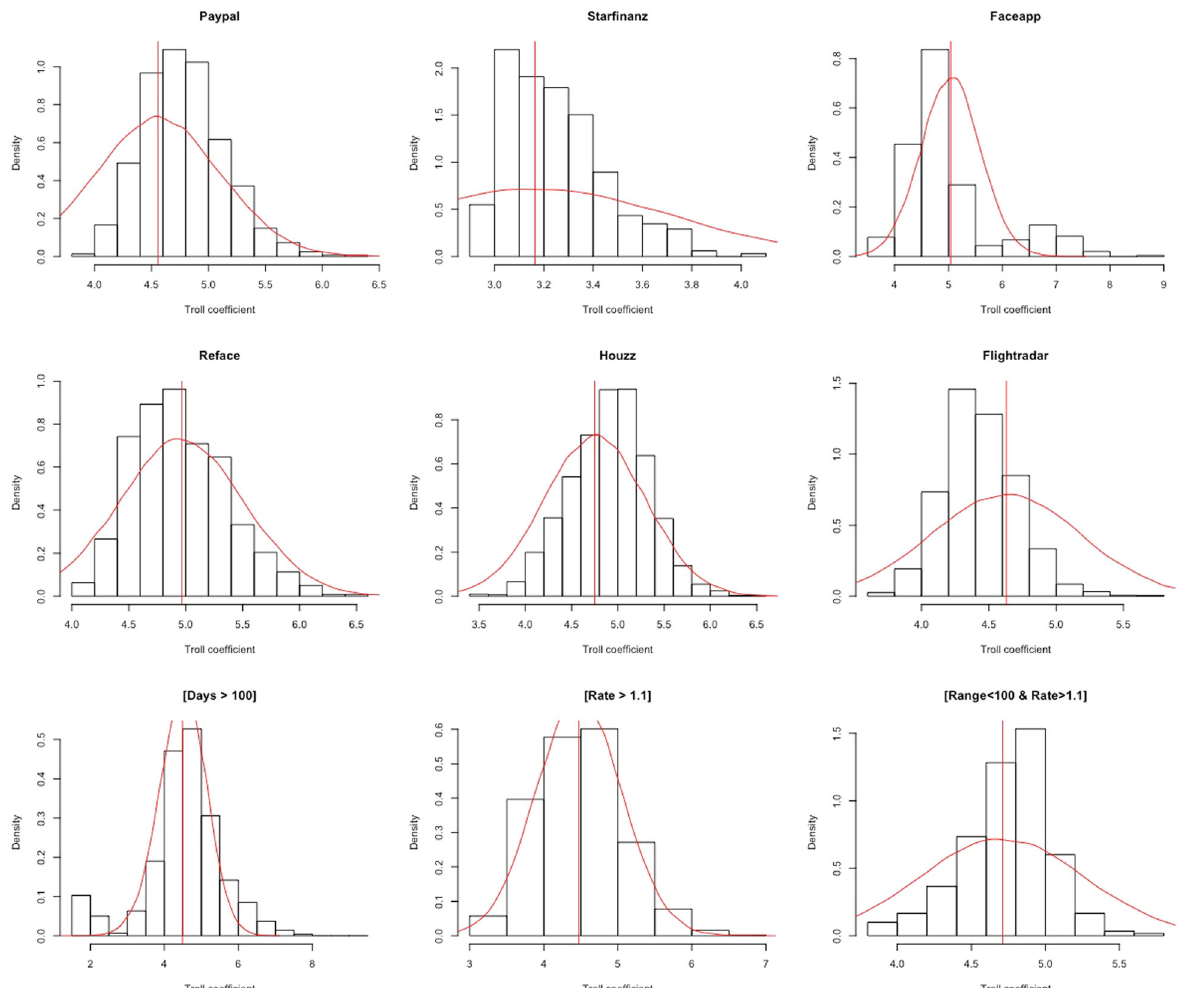
Fig. 6 Actual and replicated distributions of troll coef fi cients. Different apps and parameter values obtained by sampling from the posterior